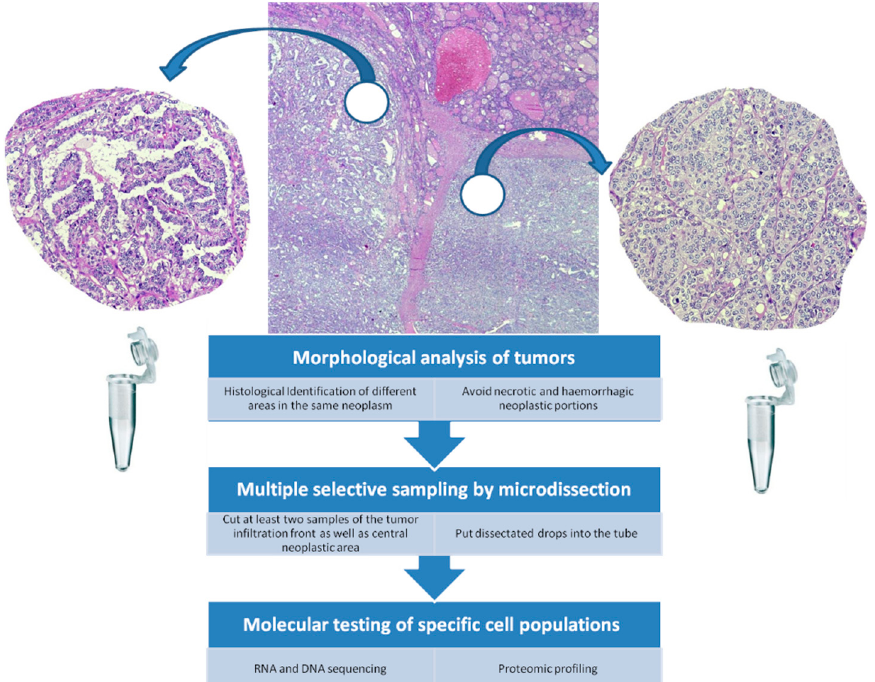
Figure 2. A schematic proposed workflow to identify ITC and to perform molecular tests in DTC.